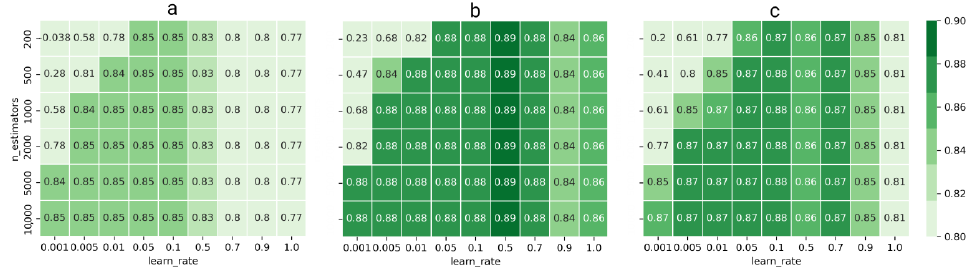
Figure 7. NSE values in hyperparameters optimization for ( a ) XGBoost, ( b ) LGBoost and ( c )